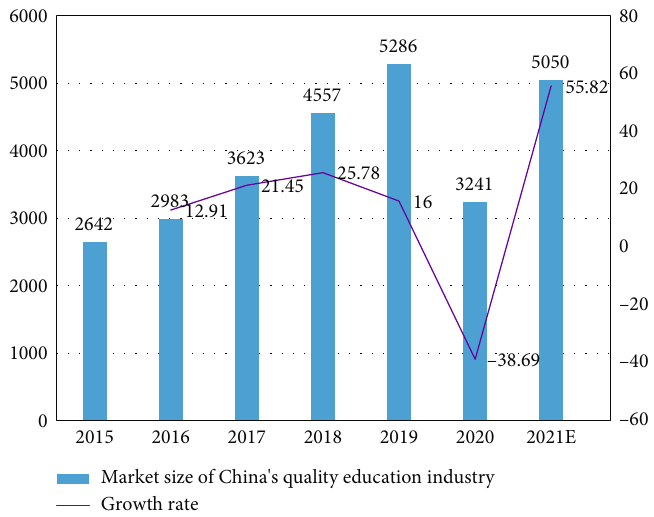
Figure 2: Market size and growth forecast of China ’ s quality education industry from 2015 to